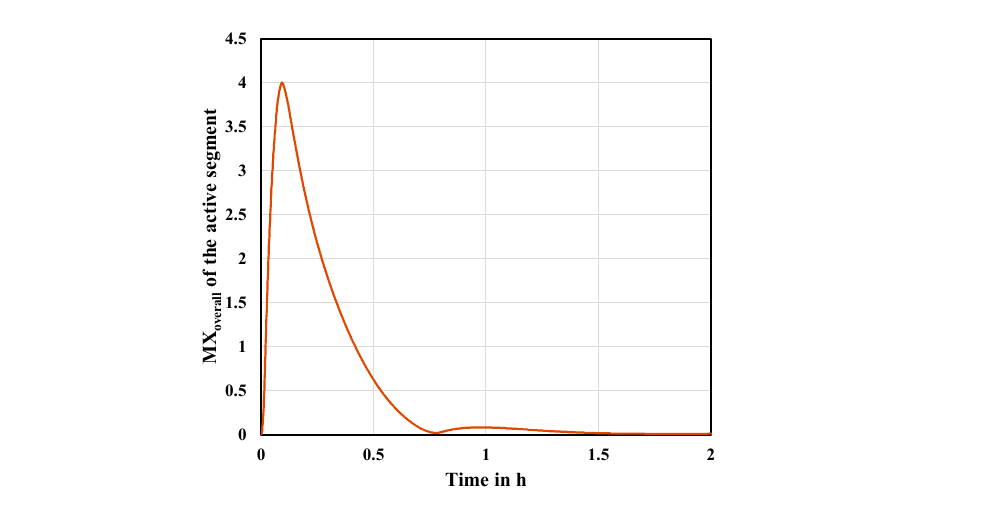
Figure 8. Overall MX-function of the active segment during activation of the adjacent segment. In case C2, the point at which the feed is introduced into the second segment is further delayed. In this way, an additional reduction in the start-up time is obtained. In comparison to the base case, the time until the distillate reaches a steady state is reduced by 57.67%. The overall time until a steady state is reached is reduced by 31.42%. As can be seen in Figure 7, the system is able to better compensate for the disturbances caused by the feed. While the gradient at the beginning is lower than in case C1 due to the reduced liquid intake to fill the column, the system is only disturbed by the later increase in the heat duty to the reboiler (cf. Figure 7 at 0.1 h). These observations coincide with the findings of Ruiz et al. [29] that, during the semi-continuous phase, compositions tend to get disturbed relatively easily by changes in other variables. The curve of the MX-function for case C2 is less affected by the effects of mixing with the feed and, thus, approaches a steady state